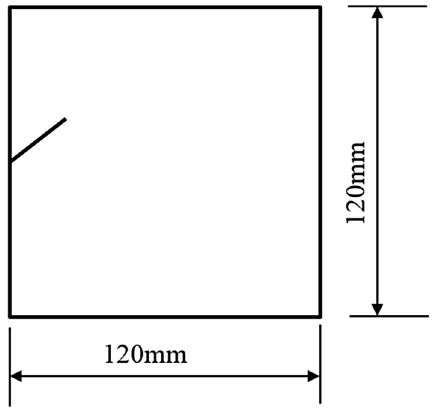
Figure 5. Precast crack orientation 2. Fissure length 2 cm, horizontal angle of fissure 40°.